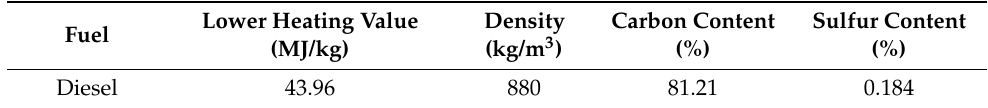
Table 3. Characteristics of the fuel for the diesel generator [25].